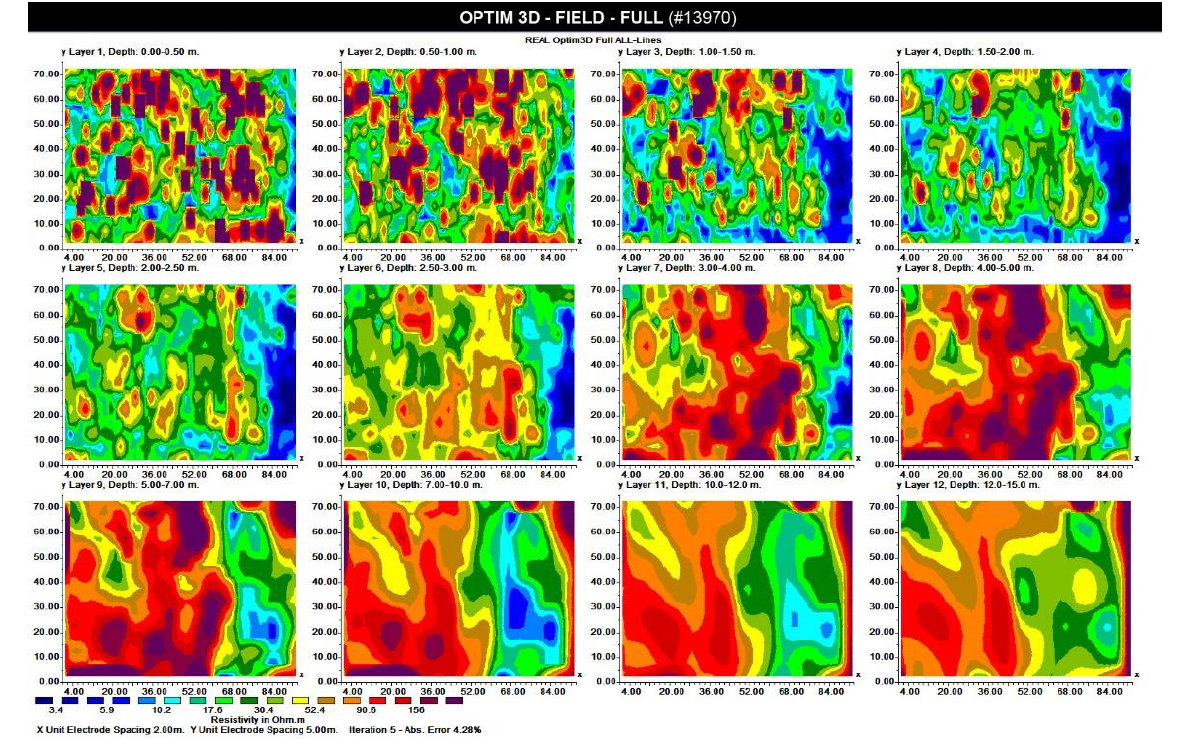
Figure 16. Inversion results from the Optim-3D field data set. Figure 15. Inversion results from the Optim-3D field data set. Figure 15. Inversion results from the Optim-3D field data set.